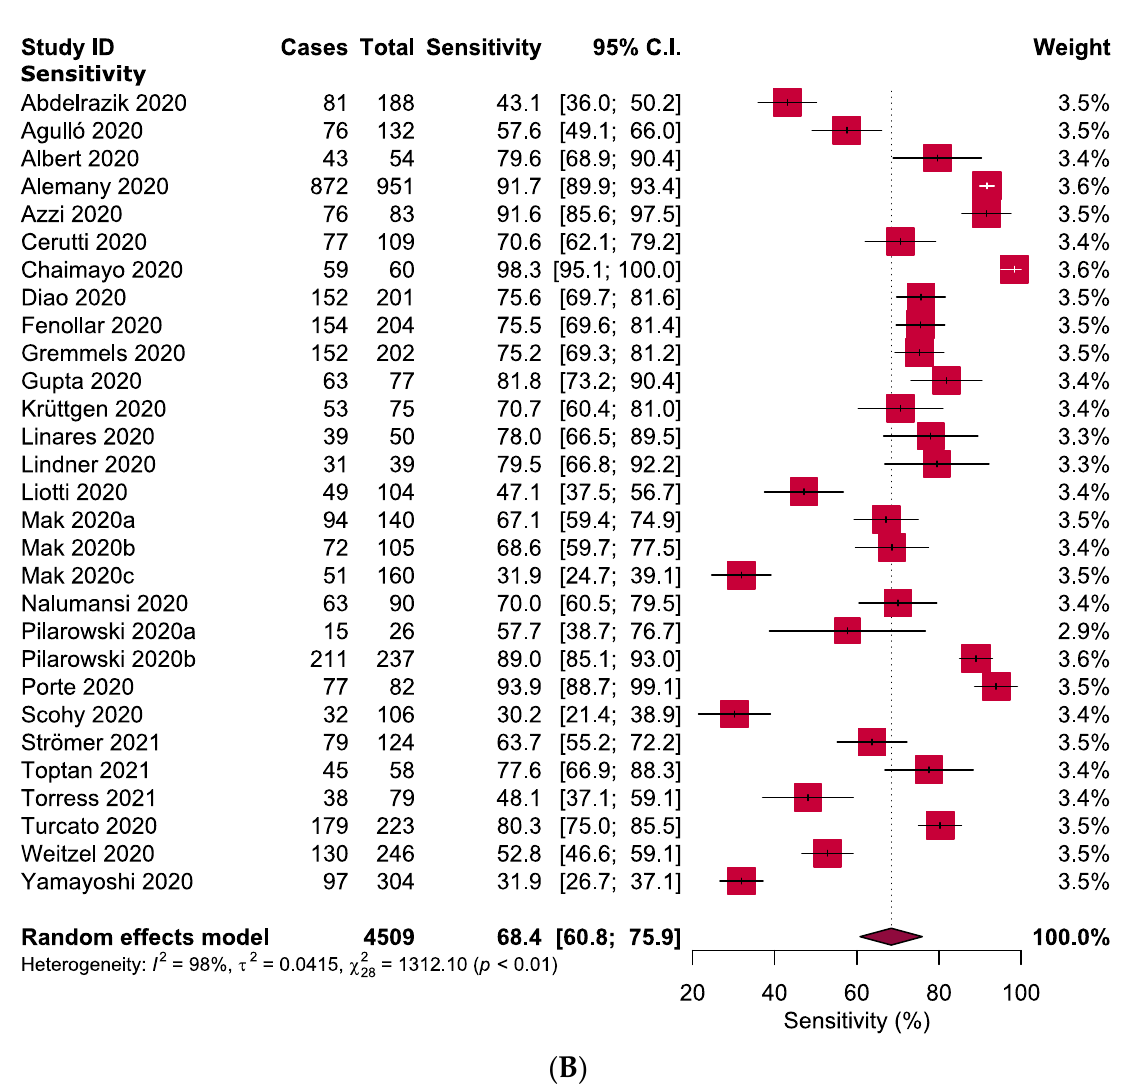
Figure 3. Forest plots representing estimating of ( A ) specificity and ( B ) sensitivity of rapid antigen tests in confirming COVID-19.